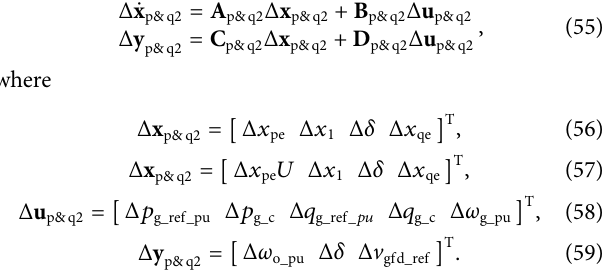
FIGURE 6 | Bode diagrams of G p compensator.